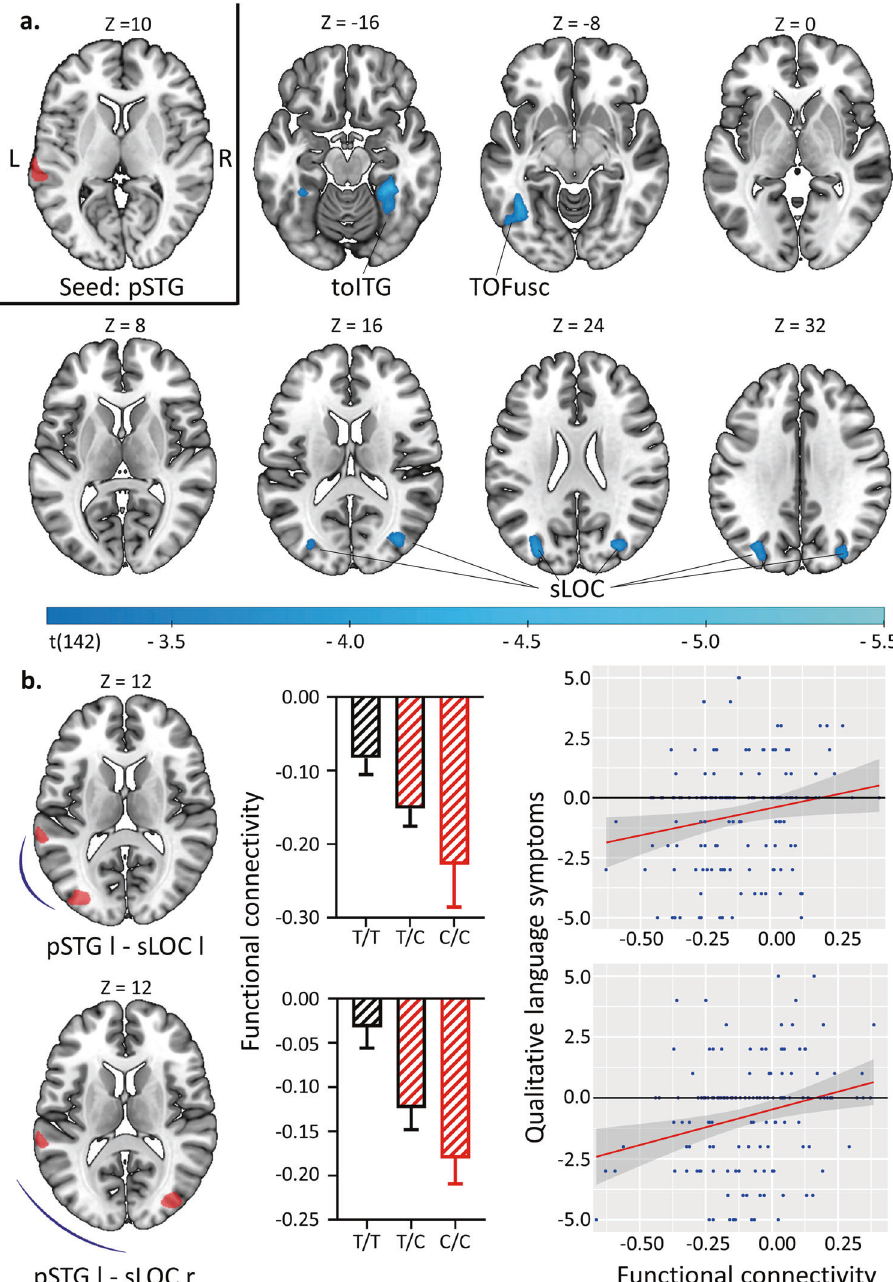
Fig. 6 Exploring neural correlates of language symptoms associated with the GRIN2A variant. Statistical parametric maps obtained from a seed-to-voxel-analysis of the left posterior superior temporal gyrus (pSTG, Wernicke ’ s area) showing clusters of decreased connectivity associated with the genetic variant (C-allele) at a voxel-wise threshold of p < 0.001 and a cluster-size threshold of p-FDR < 0.05 ( a ). Among the four different connections affected by the genetic variant, two were signi fi cantly correlated with qualitative language symptoms of the Bern psychopathology scale ( b ). Error bars represent the standard error of the mean. pSTG posterior superior temporal gyrus, toITG temporo- occipital inferior temporal gyrus, TOFusC temporo-occipital fusiform cortex, sLOC superior lateral occipital cortex, l left, r